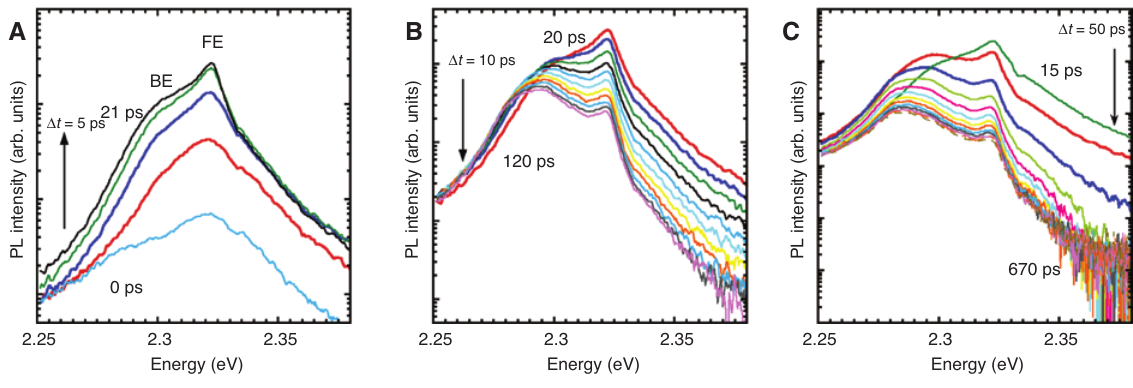
Figure 3: Bulk sample. Time-resolved photoluminescence (TR-PL) spectra (in log scale) as extracted from streak images in different time scales. For each spectrum, the time delay with respect to the excitation is reported, while Δ t corresponds to the time interval between two adjacent spectra. (A) Rise of the TR-PL, (B) early decay times, (C) longer decay